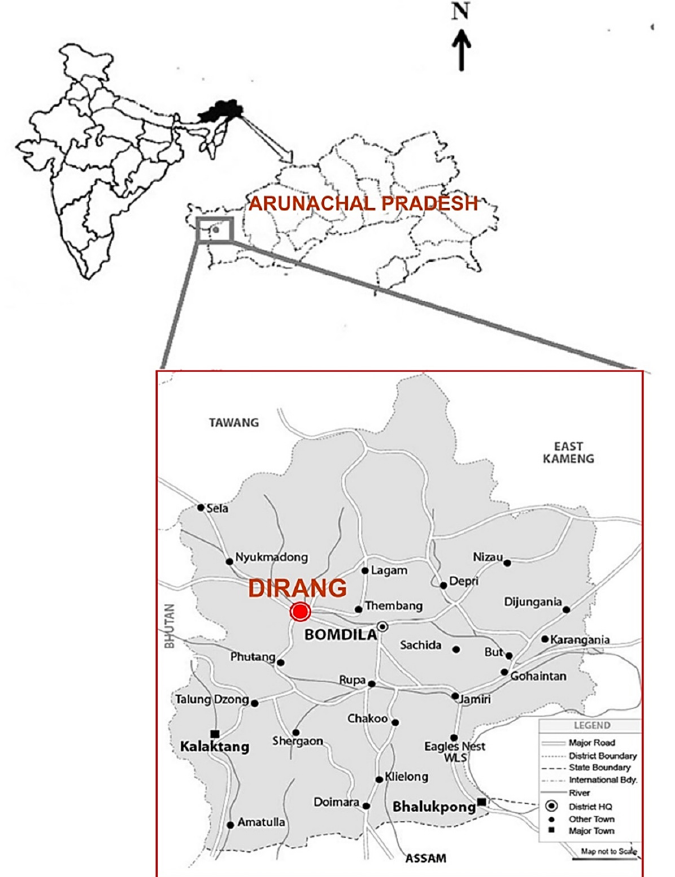
Figure 1. Study area: Map of West Kameng District, Arunachal Pradesh showing the location of Dirang